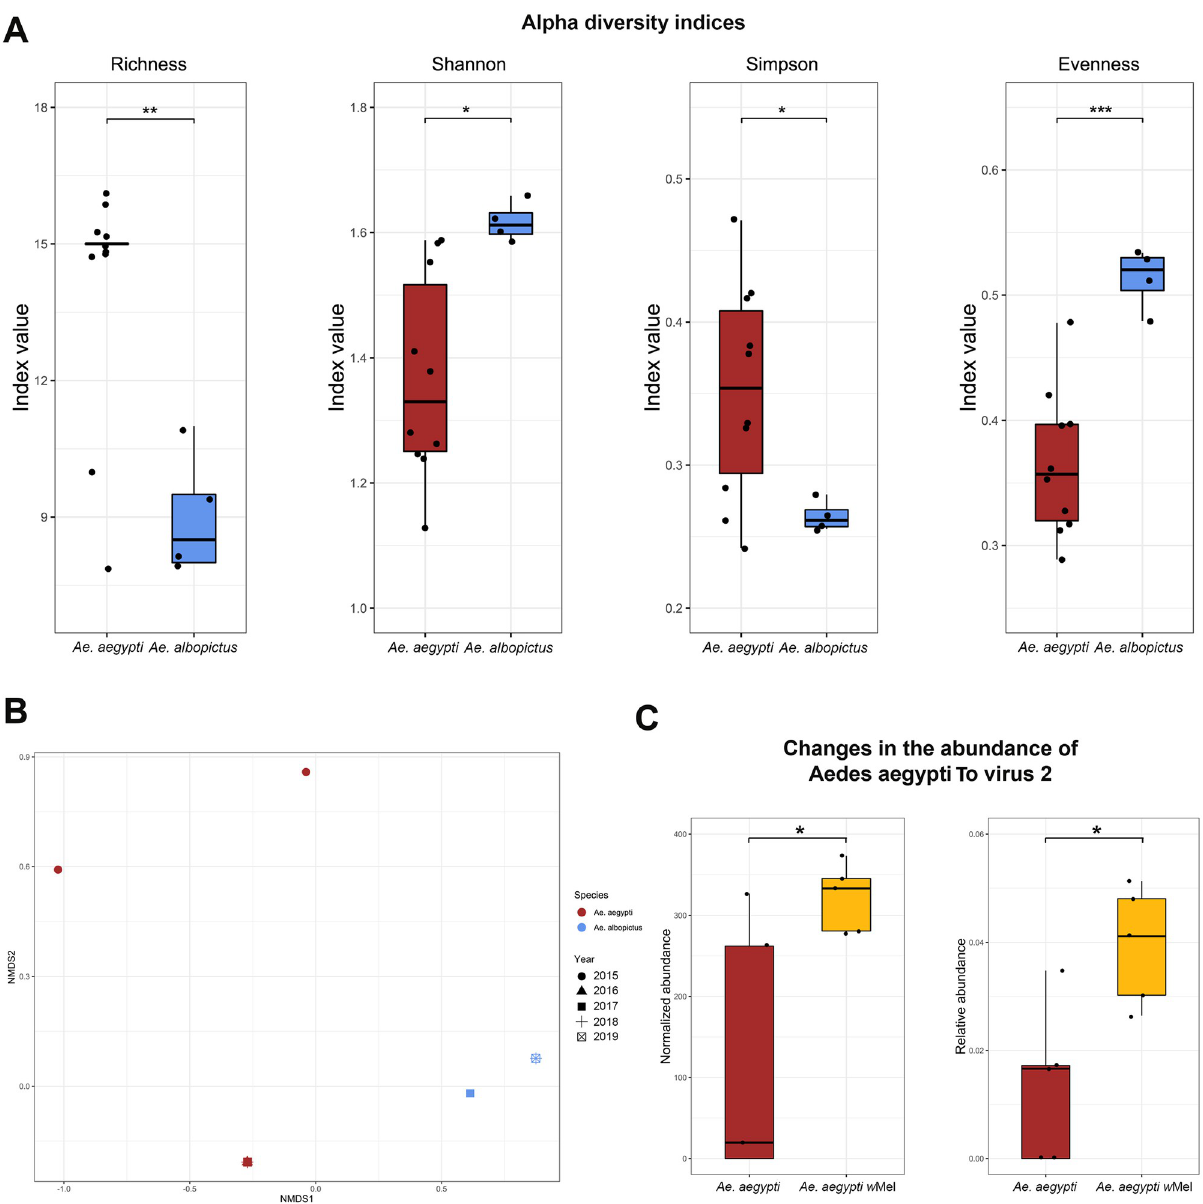
Fig 4. Diversity analysis of the Ae . aegypti and Ae . albopictus viromes. A. Alpha diversity of viruses in Ae . aegypti and Ae . albopictus at the species level. Mann–Whitney Test: p < 0.05 ( � ), p < 0.01 ( �� ), and p < 0.001 ( ��� ) . B. Nonmetric multidimensional scaling (NMDS) of viruses associated with the two mosquito species. STRESS = 0.023, PERMANOVA test on mosquito species: p = 0.004 and R2 = 0.59. C. Comparison of normalized and relative abundance levels of Aedes aegypti To virus 2 in the samples of Ae . aegypti with and without Wolbachia